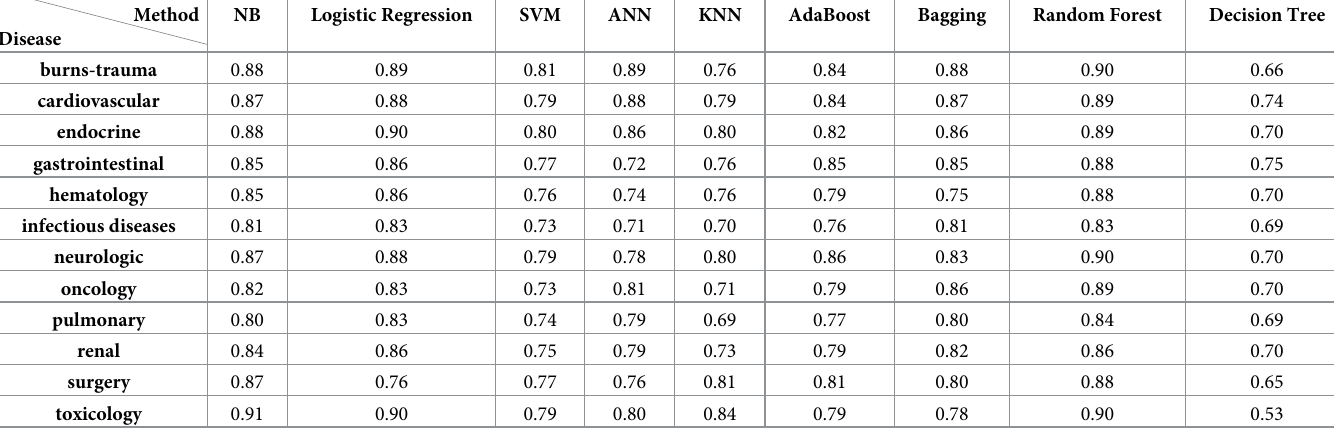
Table 2. Cross-validation results (AUROC) of the non-GBT baseline models using 10-fold cross-validation. Method NB Logistic Regression Disease